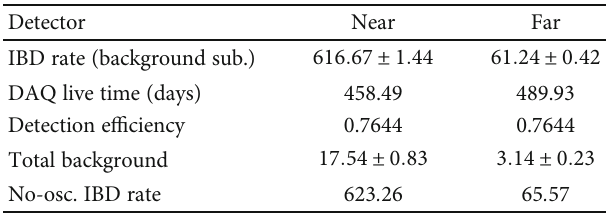
Table 2: RENO IBD rates and backgrounds per day in the 500 live days used in this work. DAQ live times are also reported for the far and near detectors. A common detection e ffi ciency was used in our simulation. Adapted from